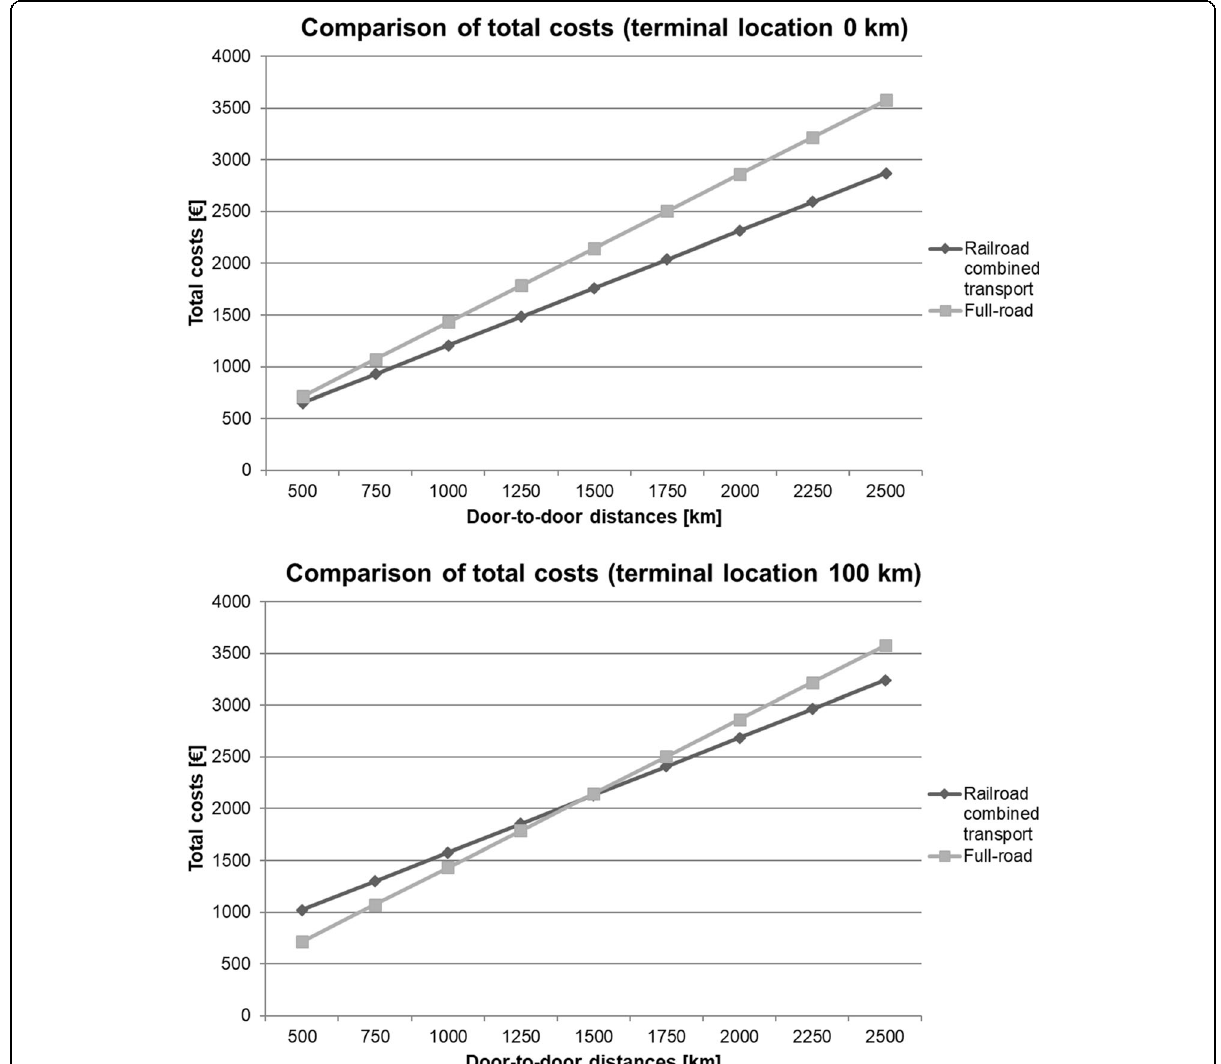
Fig. 15 Comparison of the total costs as a function of the distance between the origin and destination (drayage length: 0 km and 100 km; related to the transport of one standard ITU 40 ′